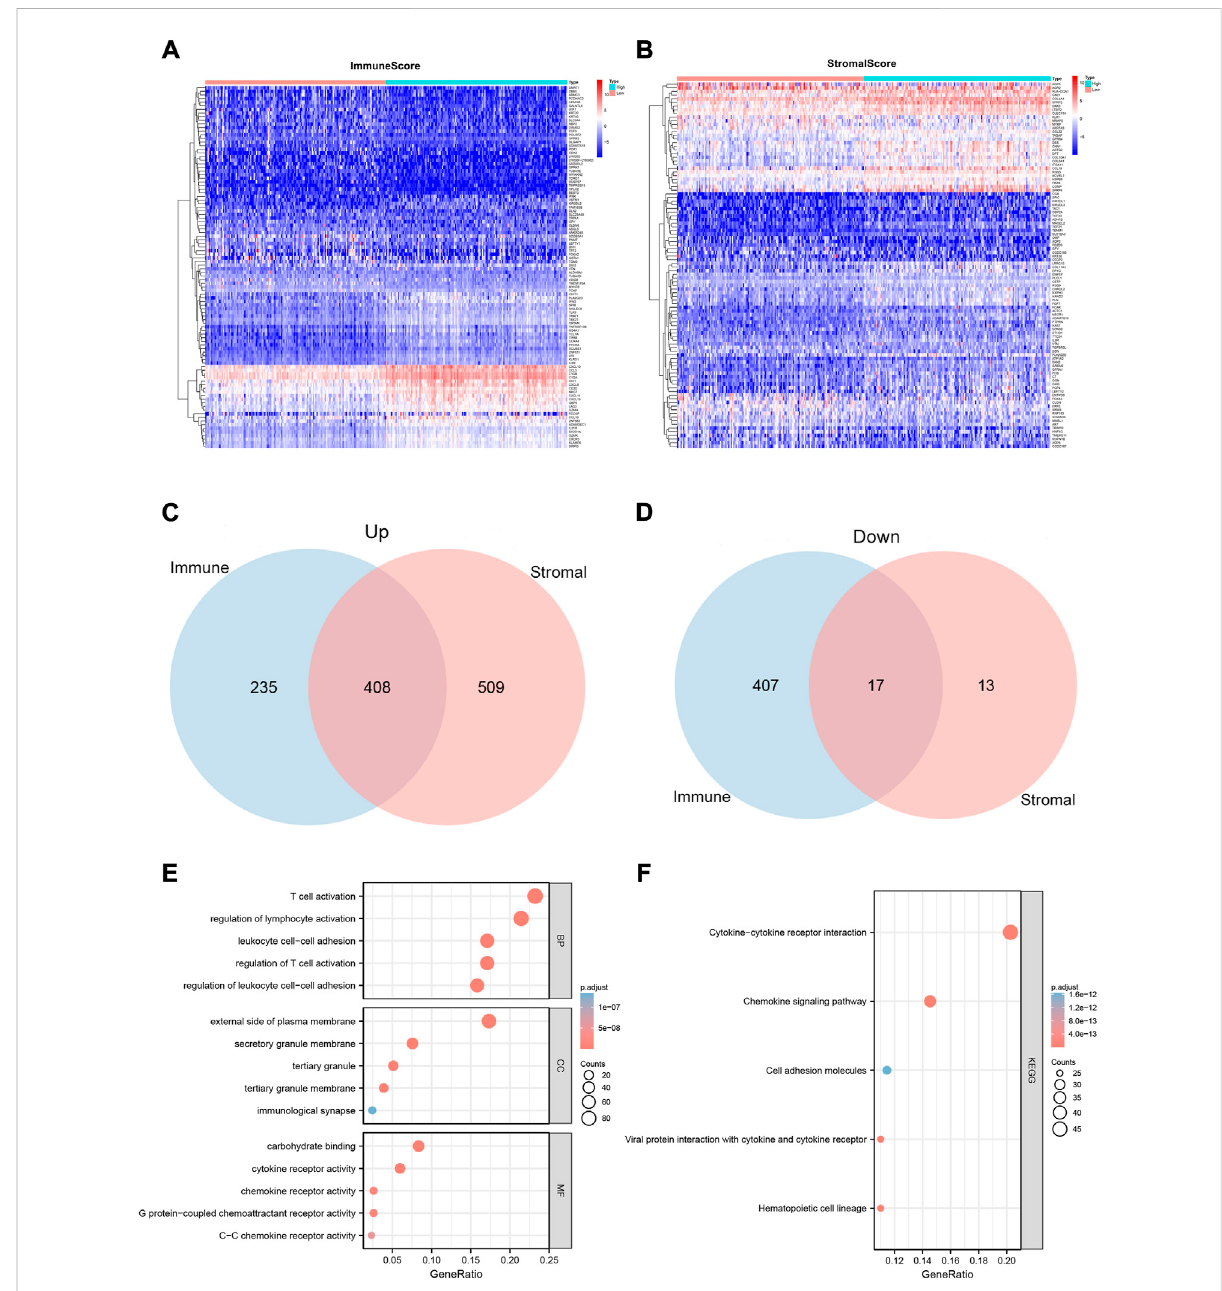
FIGURE 2 Heatmaps, Venn plots, and enrichment analysis of GO and KEGG terms for the CESC dataset. (A and B) Heatmaps for the DEGs obtained from ImmuneScore (A) andStromalScore (B) ,generatedbycomparinghigh-scoringandlow-scoringgroupsofimmuneandstromalcells. (CandD) Venn diagram analysis of up-regulated (C) and down-regulated (D) DEGs shared by the ImmuneScore and StromalScore. (E and F) Biological functions (E) and pathway (F) enrichment analyses for DEGs in the CESC dataset with p -value and q -value <